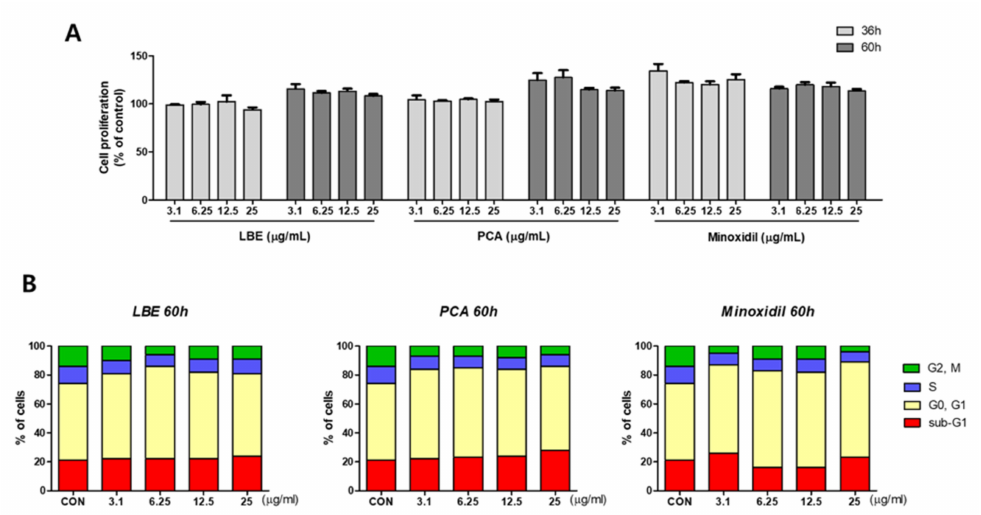
Figure 5. Effects of LBE, PCA, and minoxidil on hair regeneration in human papilla cells: ( A ) cell proliferation of LBE, PCA, and minoxidil in human dermal papilla cells. Cells were treated with various concentrations of LBE, PCA, and minoxidil for 36 h and 60 h. Minoxidil was used as a positive control. Representative data of each group are expressed as mean ± SD. ( B ) The effect of LBE, PCA, and minoxidil on the cell cycle in human dermal papilla cells.: cells were treated with LBE, PCA, and minoxidil at various concentrations for 60 h; cell cycle stages (sub G1, G0/G1, S, G2/M) were measured using a Tali image-based